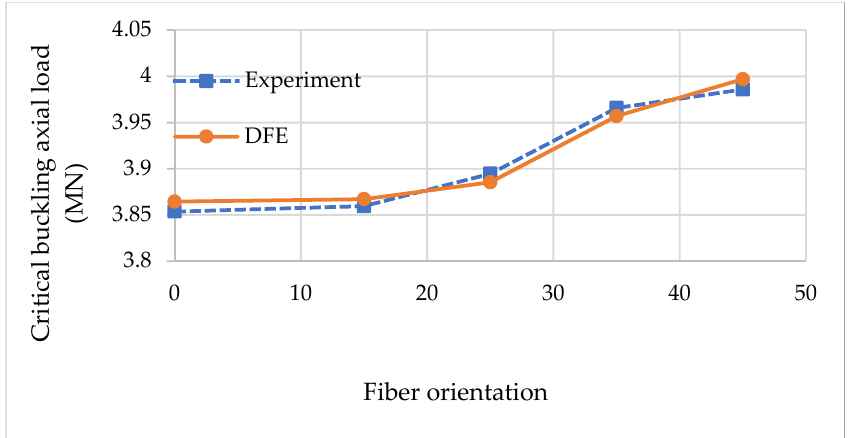
Figure 6. Critical buckling load vs. fiber orientation for FML using DFE with Mzz = 0, in comparison with experimental results [36].